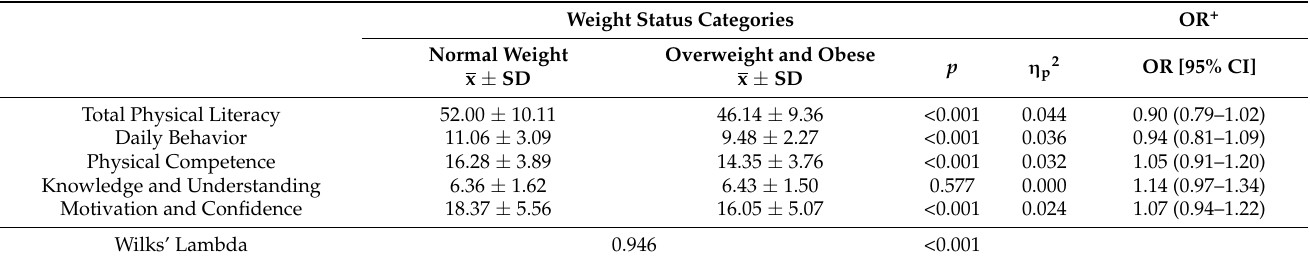
Table 7. The statistical association between the weight status, PL, and domains scores. Weight Status